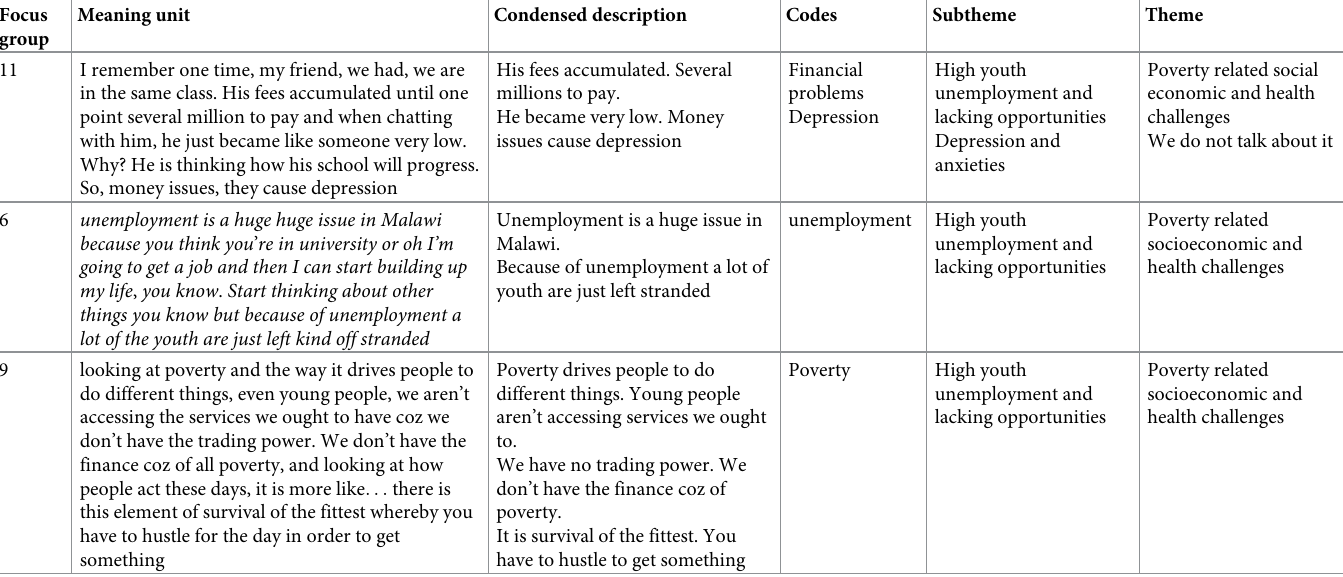
Table 3. Example of content analysis